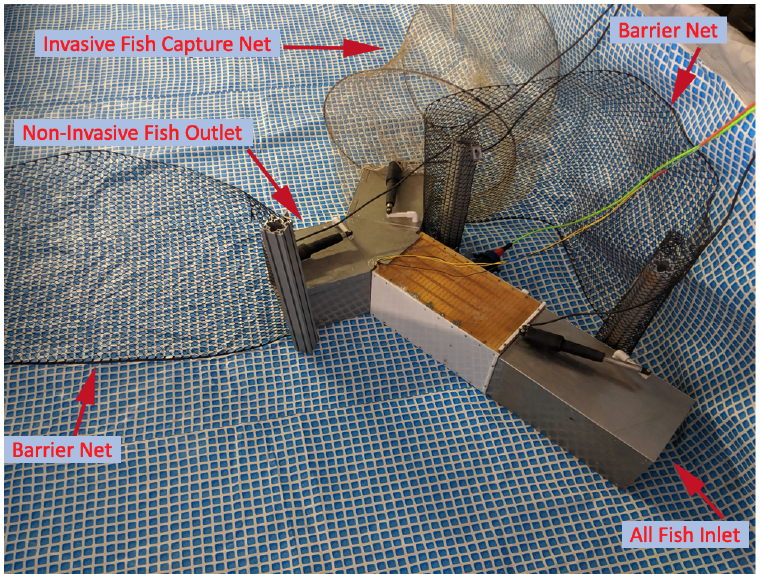
Figure 6. Deployment of the fish separation